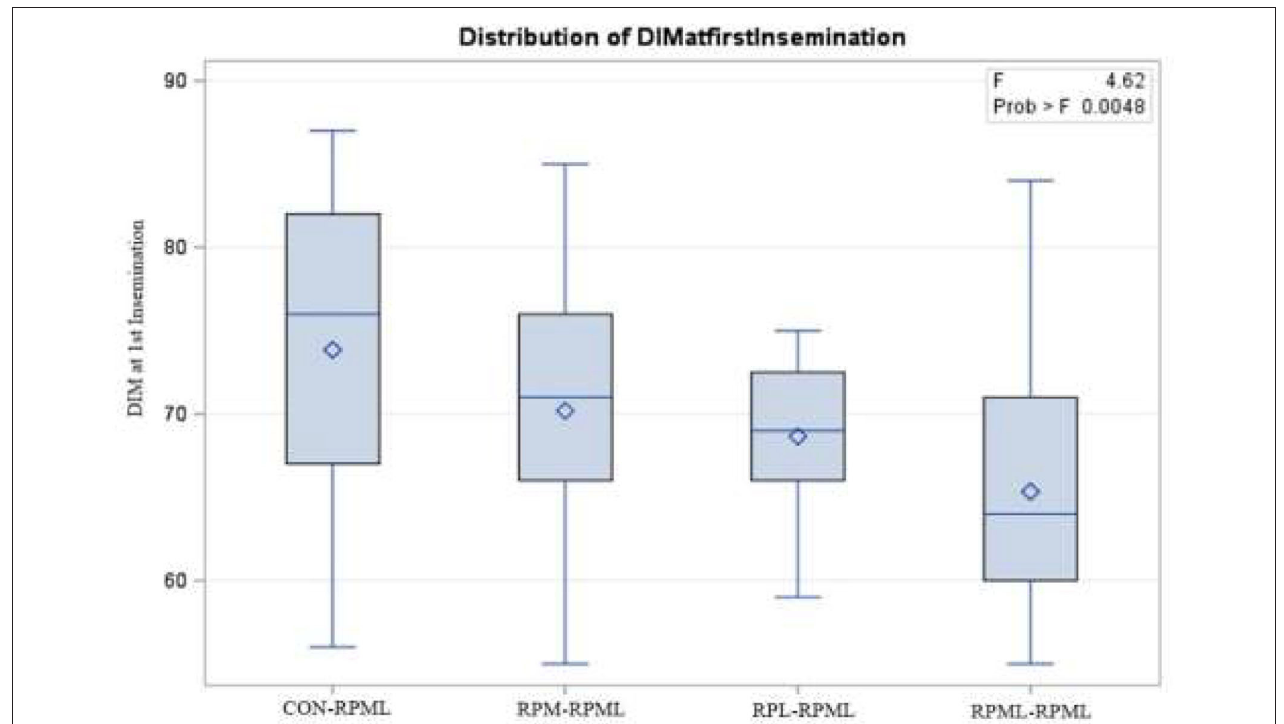
FIGURE 10 | Effect of supply ruminally protected Met and Lys to transition and milking dairy cows on days to 1st insemination. Values are means; standard errors are represented by vertical